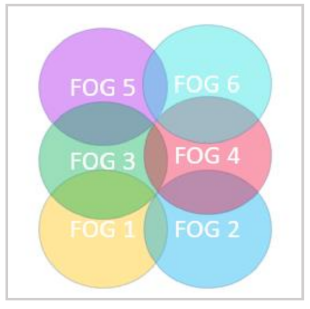
Figure 4. Overlapping Fog